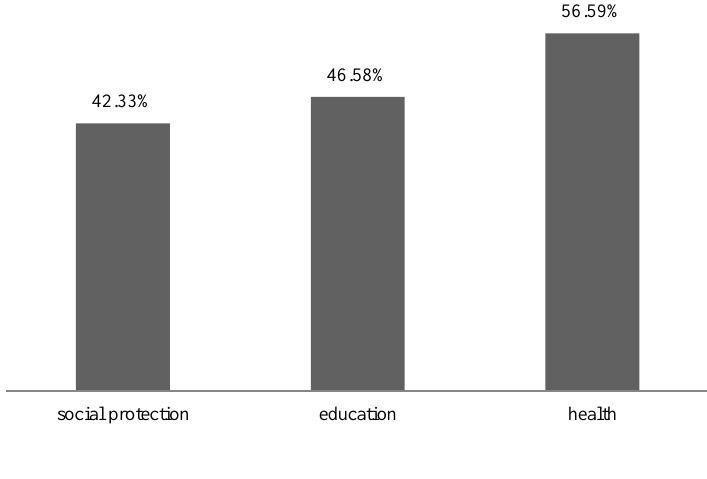
Figure 2. Efficiency in limiting poverty and income inequality of government social spending by function in the EU